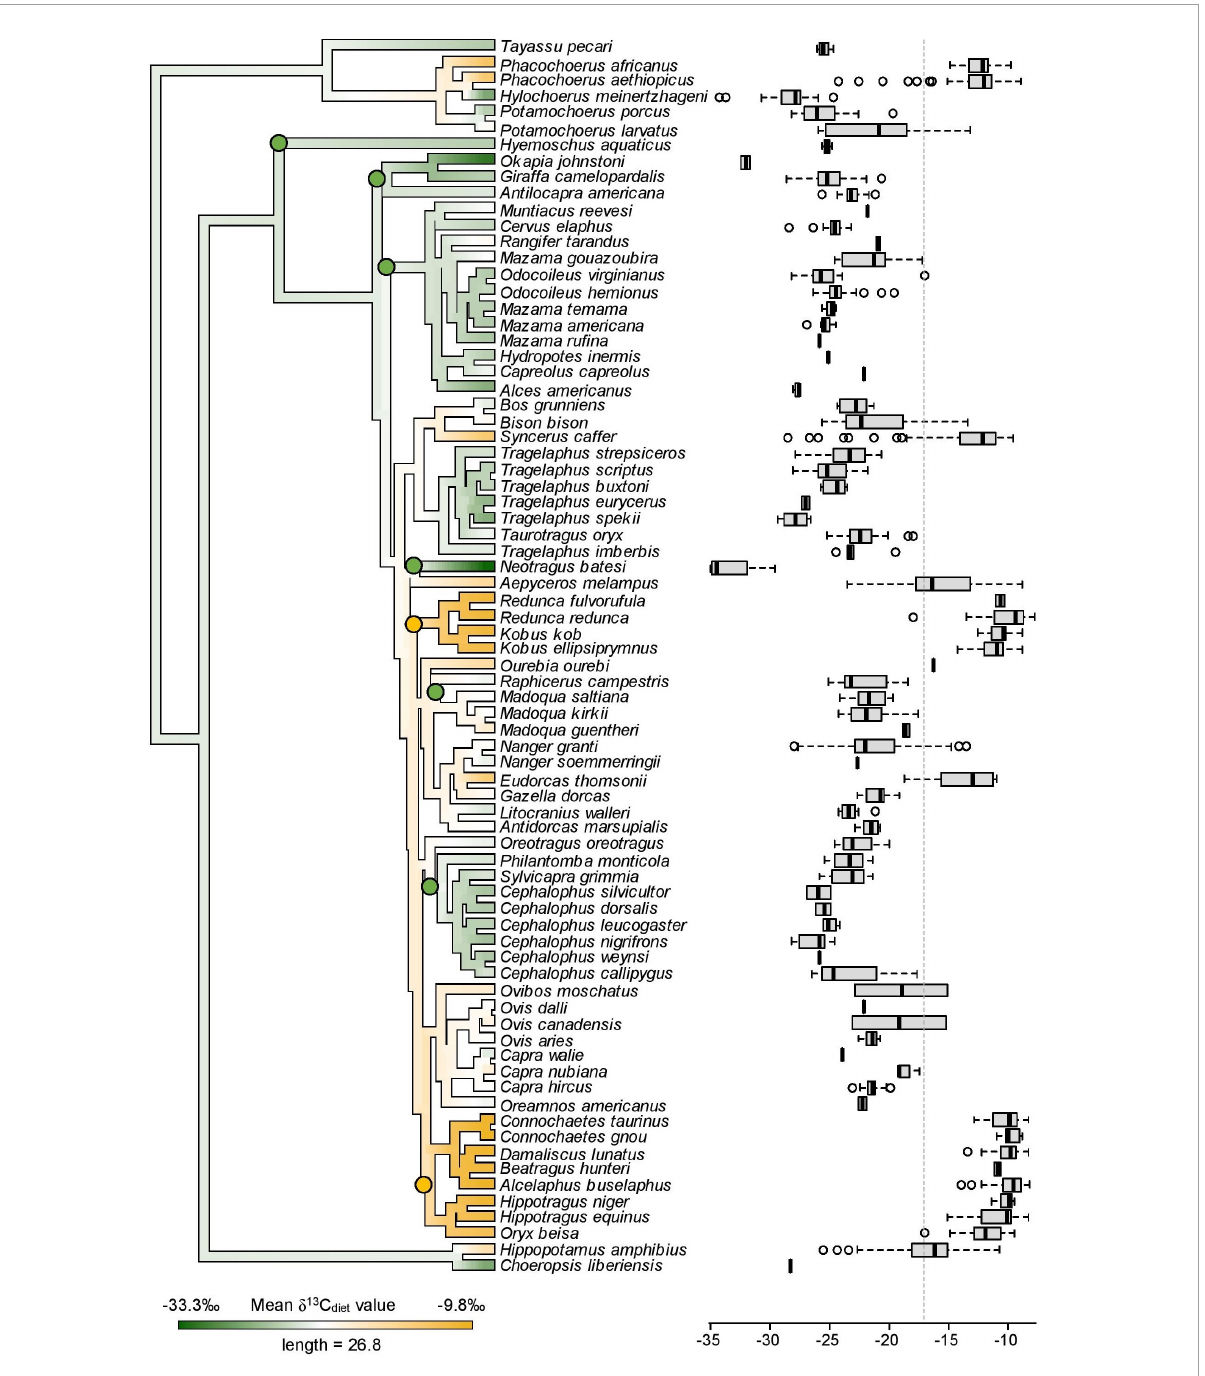
FIGURE6 Mean δ 13 C diet values of 76 species mapped onto the artiodactyl phylogeny and boxplots showing the distribution of individual δ 13 C diet values in each species. A low phylogenetic signal is detected in mean δ 13 C diet values ( K = 0.38, p = 0.001). Labeled nodes mark clades that are mentioned in the text. Green nodes = C 3 feeders. Yellow nodes = C 4 feeders. Dashed vertical line is the C 3 -C 4 boundary.